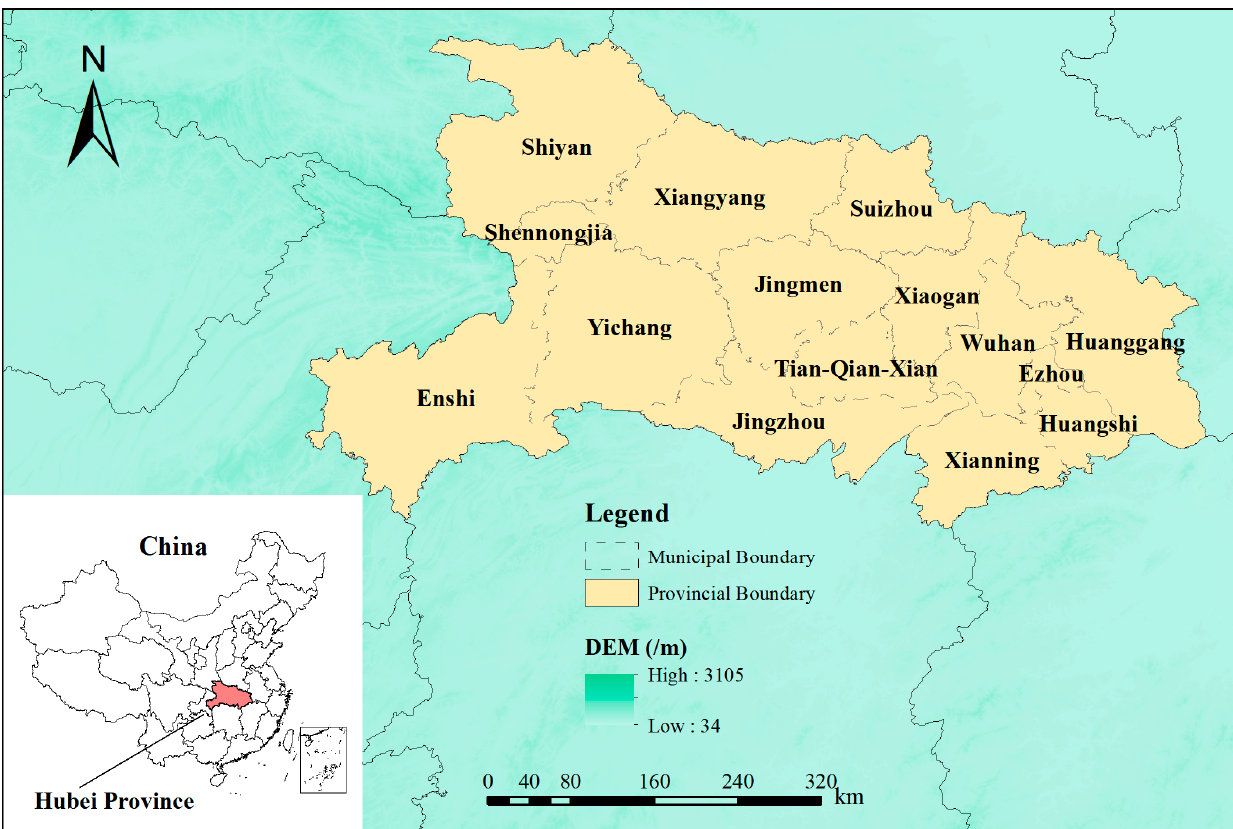
Figure 1. The location of the target study area.